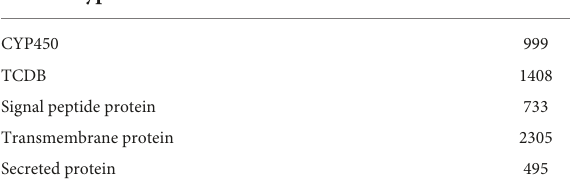
FIGURE7 Carbohydrate activity enzyme annotation results.